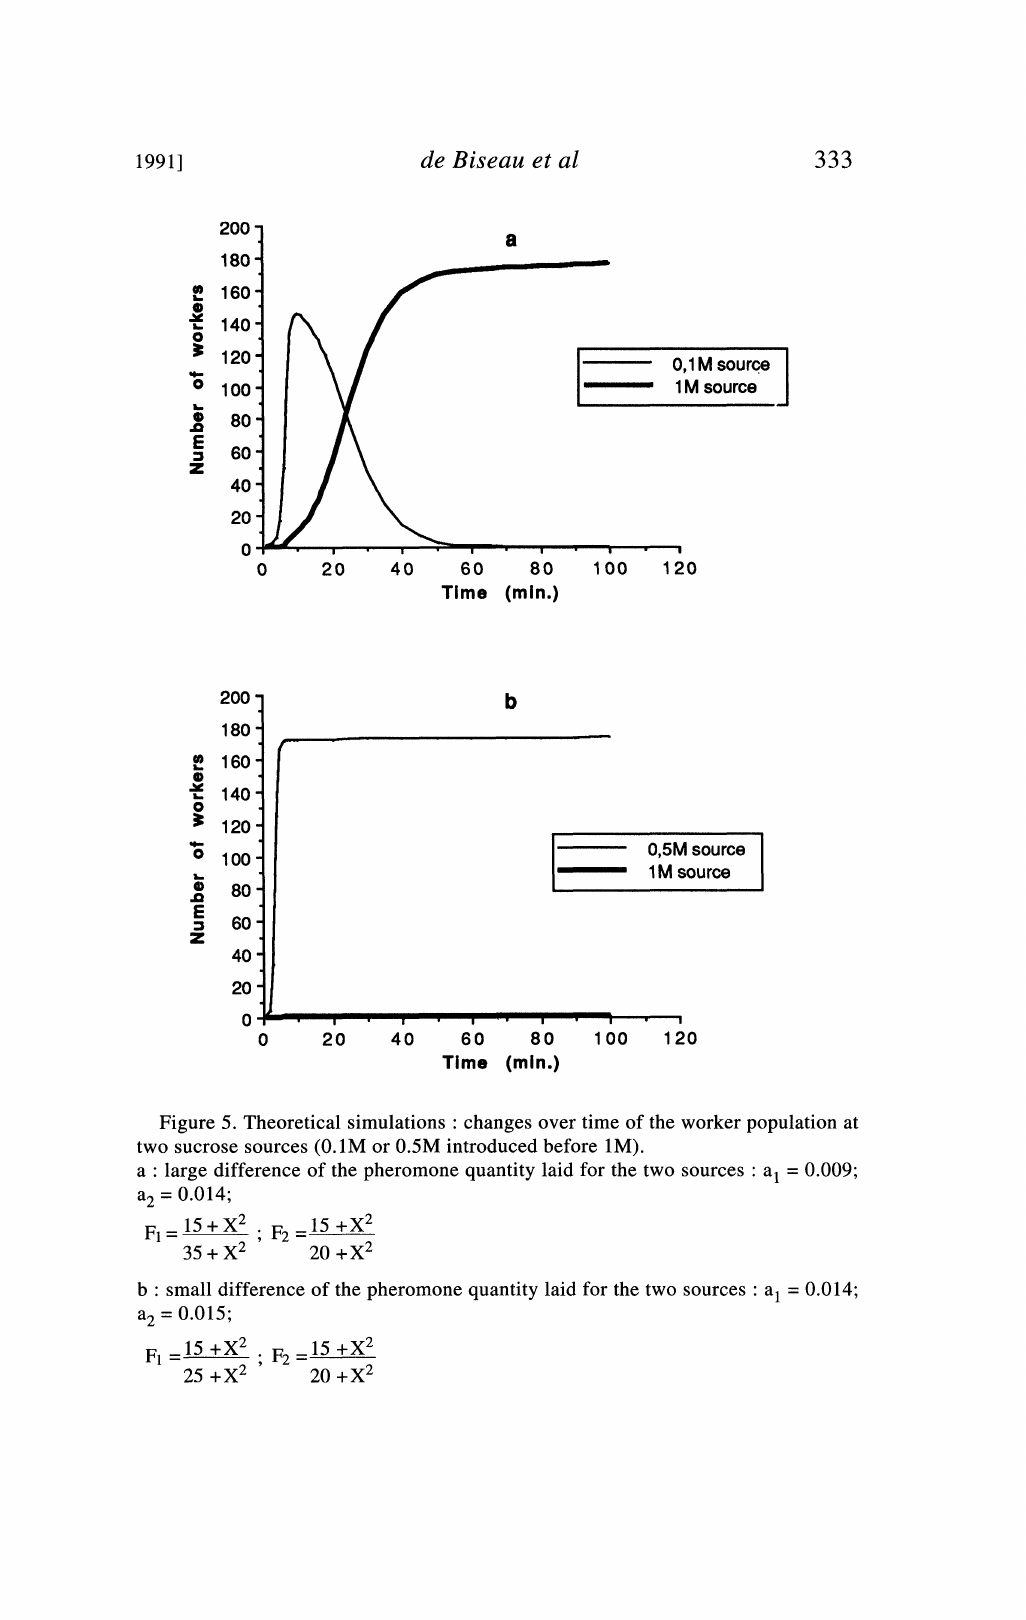
b small difference of the pheromone quantity laid for the two sources